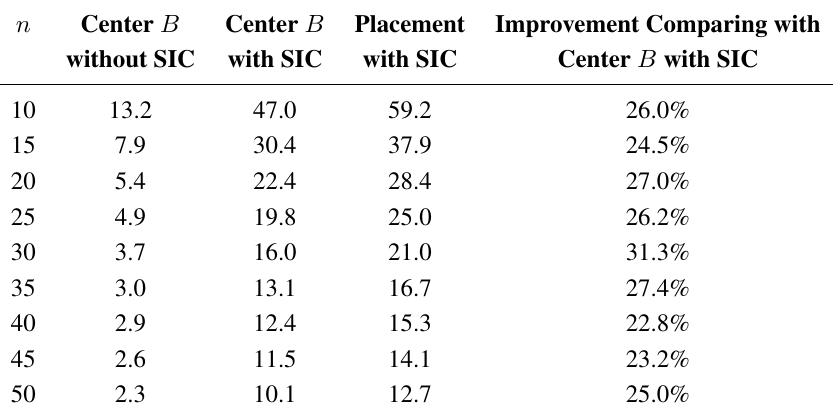
Table 3. Optimization results for base station